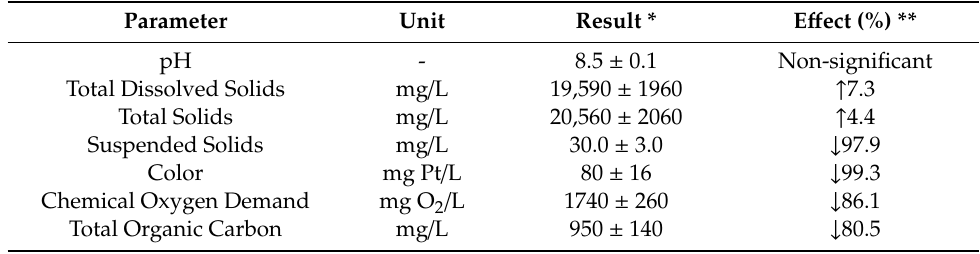
Table 9. Selected physicochemical parameters of treated tannery wastewater after RSM